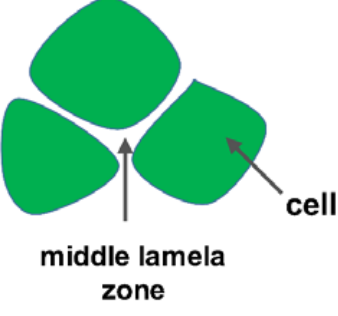
Figure 4. Structure of the plant tissue and the zone where the middle lamella is situated.